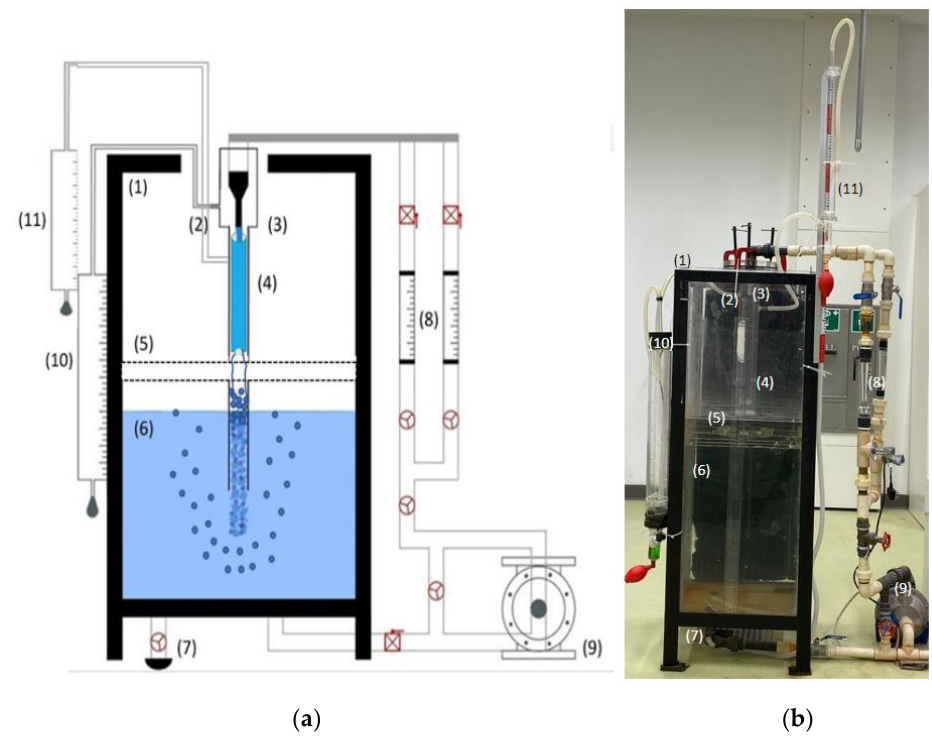
Figure 3. ( a ) The upgraded CPLJR apparatus with two bubble meters for measuring both entrainment and disentrainment rate: (1) tank, (2) tapping, (3) nozzle, (4) ADR, (5) supporting flange/frame, (6) receiving pool, (7) drainage outlet, (8) rotameters, (9) pump, (10) bubble meter 1, (11) bubble meter 2, ( b ) picture of the upgraded CPLJR apparatus in the laboratory in College of Life Sciences, Kuwait University.